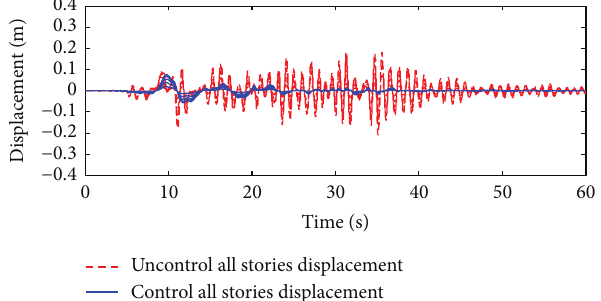
Figure 8: Time history graphs of control force for all stories under Bam Earthquake when synchronized control coupled with 𝐻 2 / LQG is used.